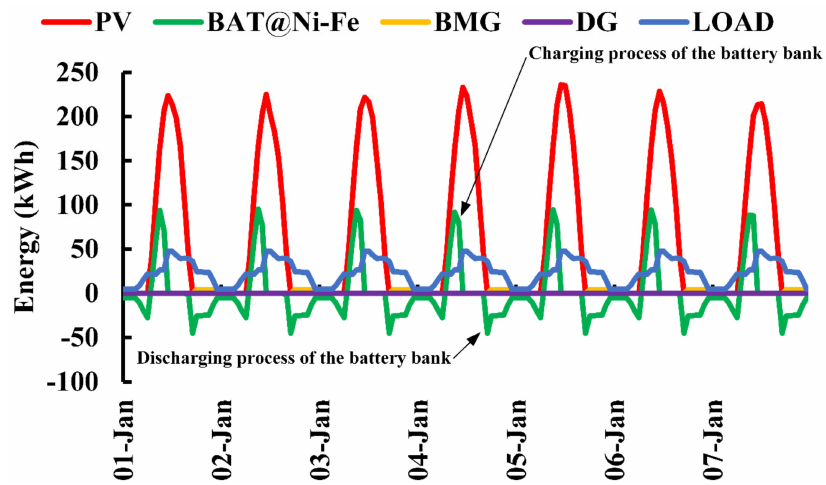
Figure 17. During one week of the winter season in January, energy outputs of various components of the Ni-Fe battery-based IHRES with LF strategy using LPRAHC